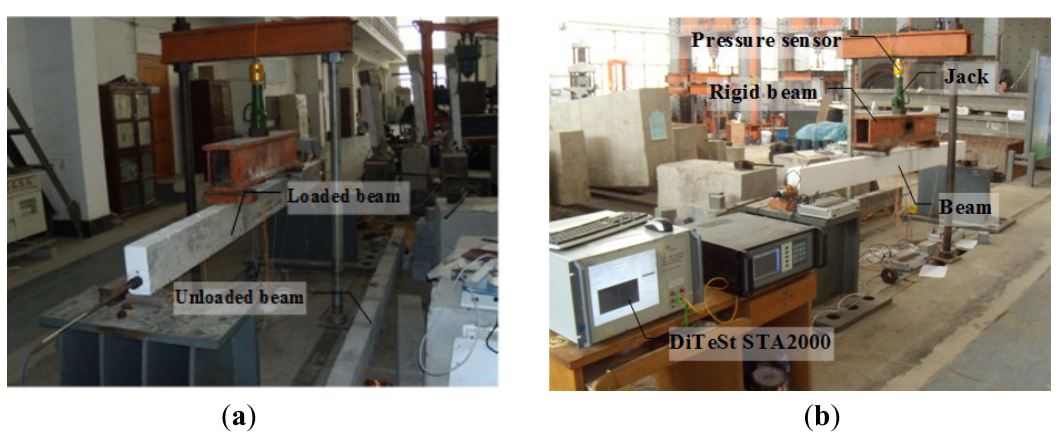
Figure 9. Experimental setups of prestress losses monitoring test. ( a ) Two experimental beams; and ( b ) Experimental